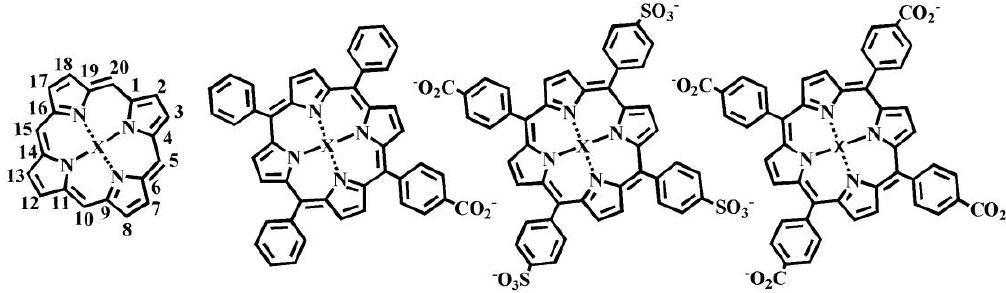
TPP). Metal complex 4